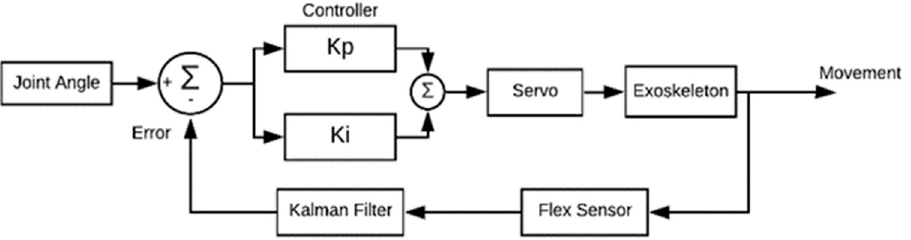
Figure 13. Feedback Control diagram for the opening and closing of fingers.